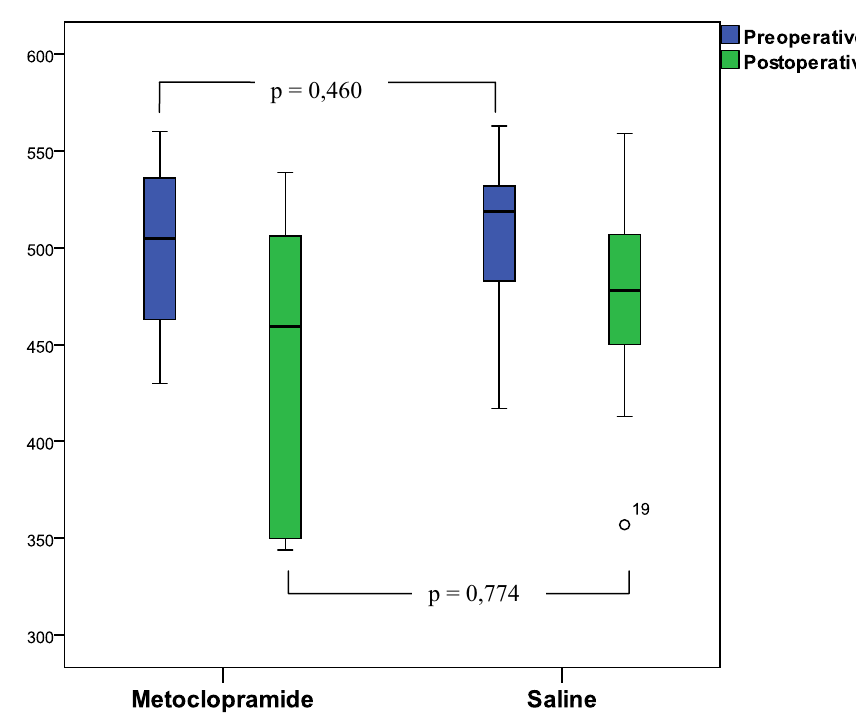
FIGURE 2 - Weight of animals euthanized on the 7 th postoperative